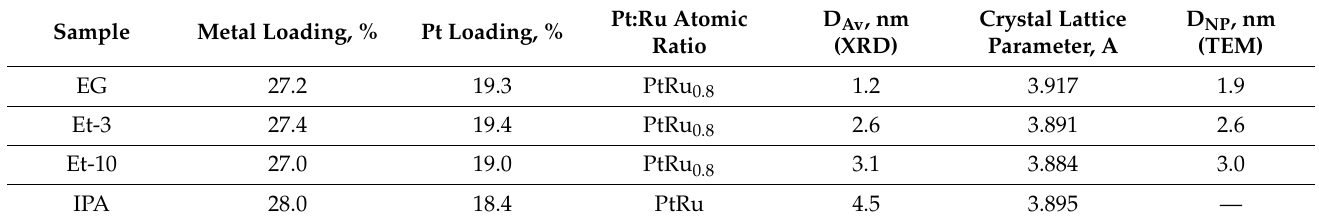
Table 1. Composition, phase, and structure of the platinum-ruthenium materials.